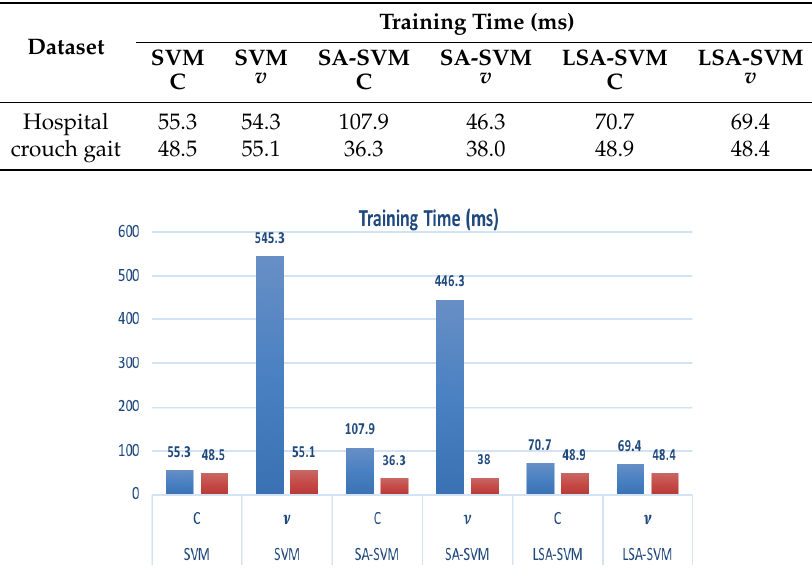
Table 5. The training time consumption for each type of classifier.